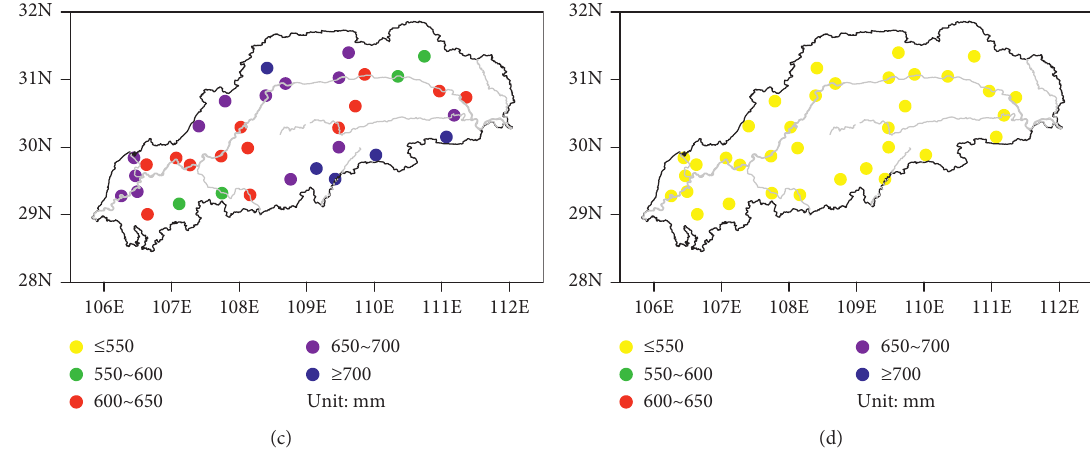
Figure 21: The spatial distribution of R95 calculated from (a) gauge observation, (b) TRMM, (c) CMORPH, and (d) PERSIANN at each rain-gauge station.